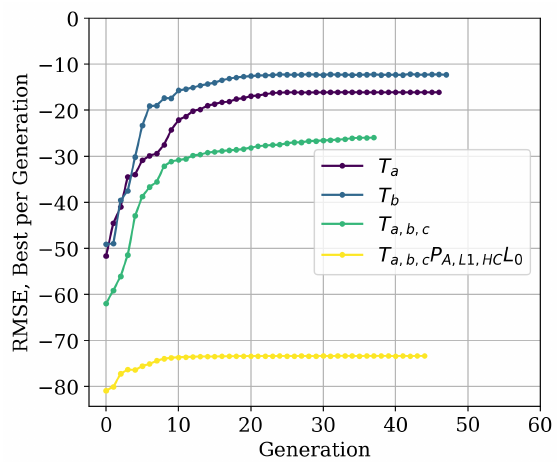
and T a , b , c P A , L 1, HC L 0 ). ∗